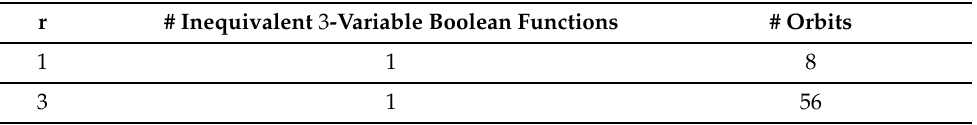
Table 1. Number of inequivalent m -variable Boolean functions of weight r under the affine equiva- lence for m = 3 and r =